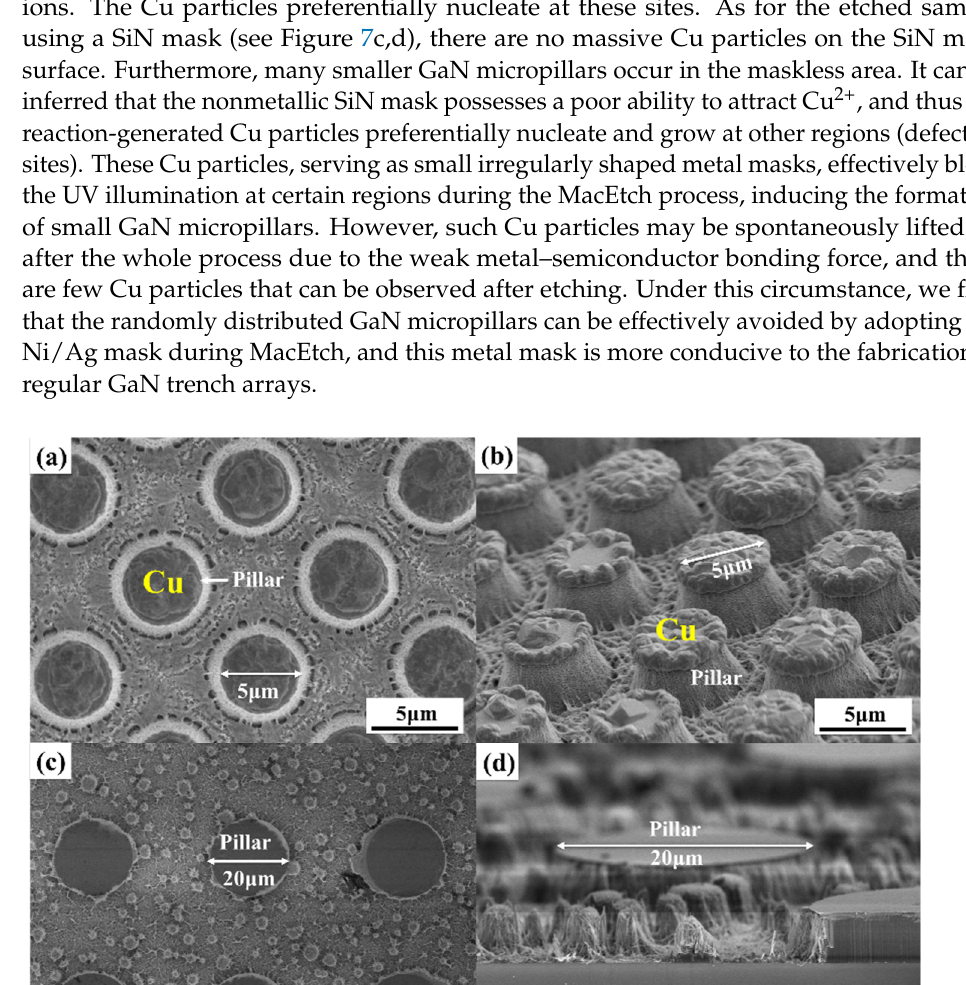
Figure 8. Cross-sectional SEM images (45°-tilt view) of the GaN micropillar arrays obtained with etchants containing different HF concentrations: ( a , b ) 5 M and ( c , d ) 10 M.